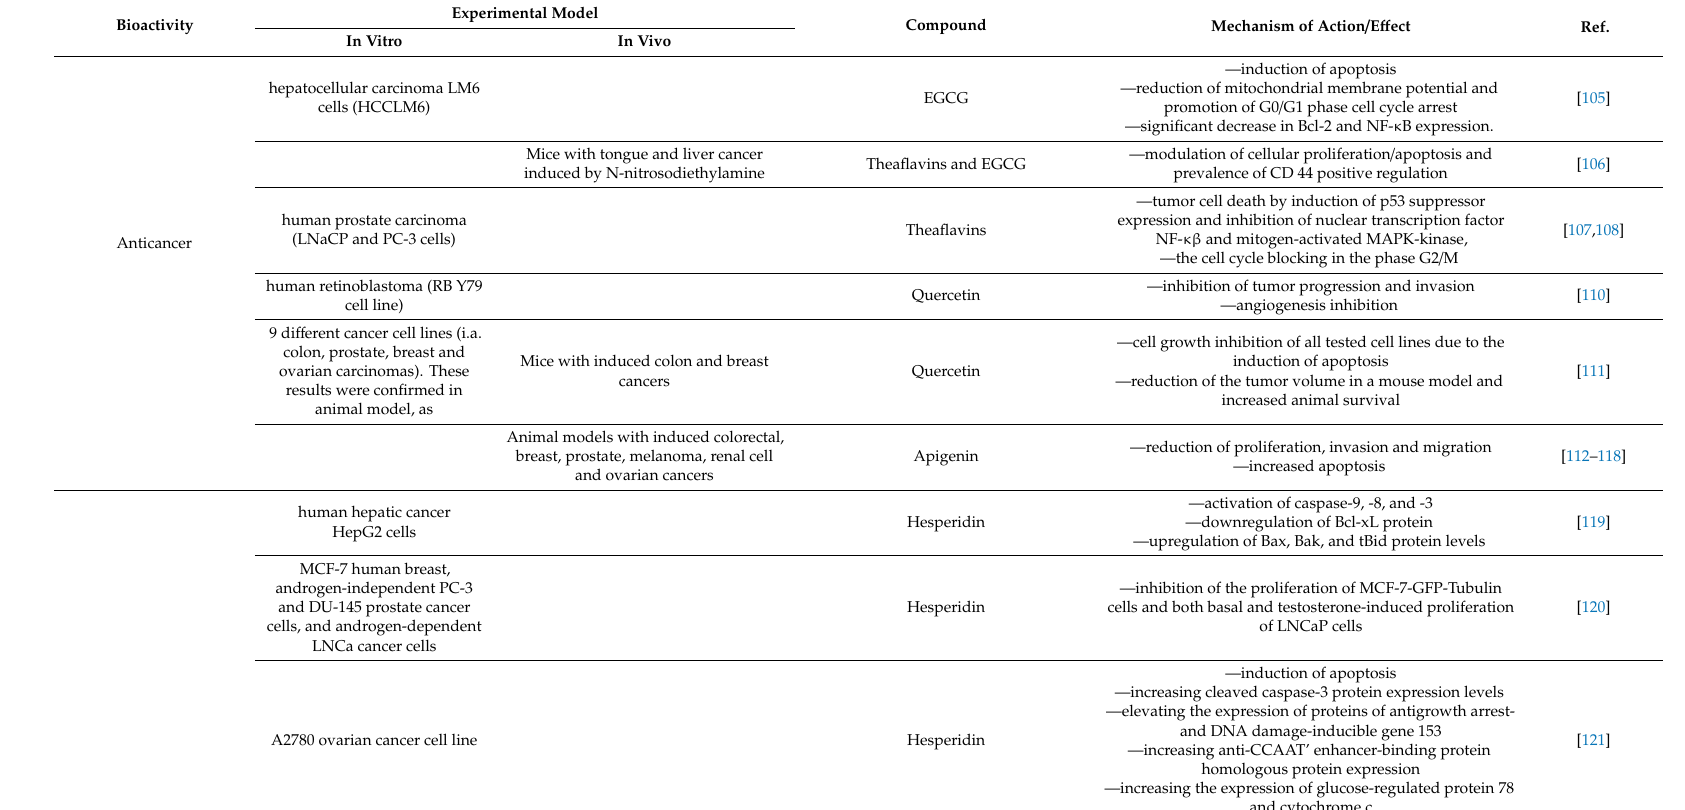
—induction of apoptosis —increasing cleaved caspase-3 protein expression levels —elevating the expression of proteins of antigrowth arrest- and DNA damage-inducible gene 153 —increasing anti-CCAAT’ enhancer-binding protein homologous protein expression —increasing the expression of glucose-regulated protein 78 and cytochrome